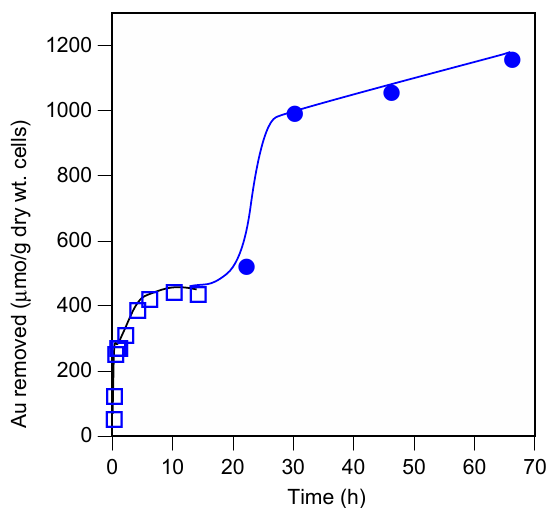
Figure 2. The time course of gold removal using C. krusei AHU3993. Symbols: square (biosorption), circle: (biomineralization).